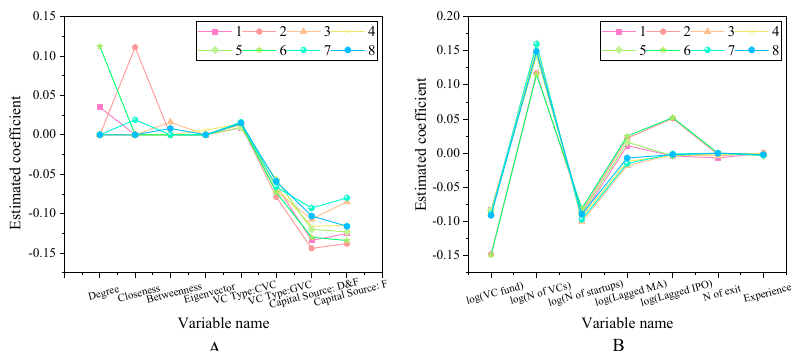
Figure 7. The impact of venture capital social network on successful exit rate ( A ) The first eight variables. ( B ) Other